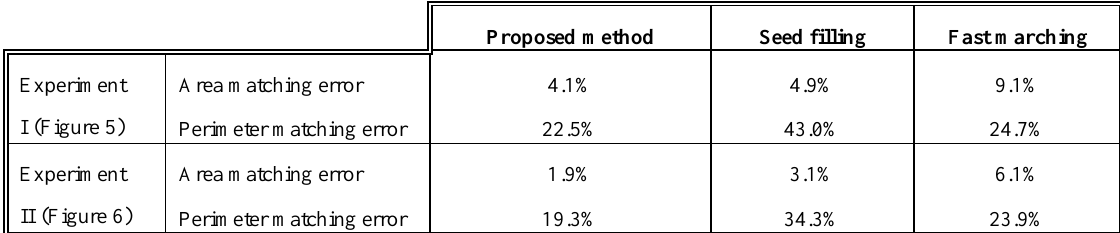
Table 1. Accuracy assessment between the proposed, seeding filling, and fast marching